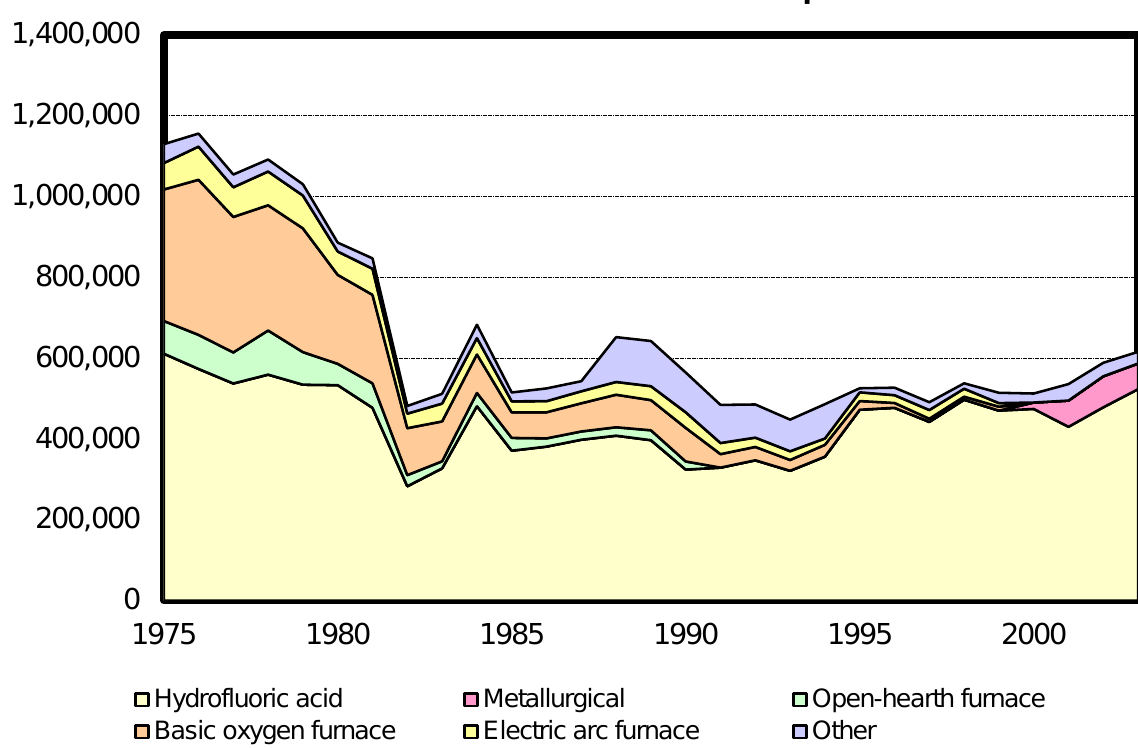
Figure 3. United States Geological Survey data showing the uses of fluorspar over the last few decades is illustrated